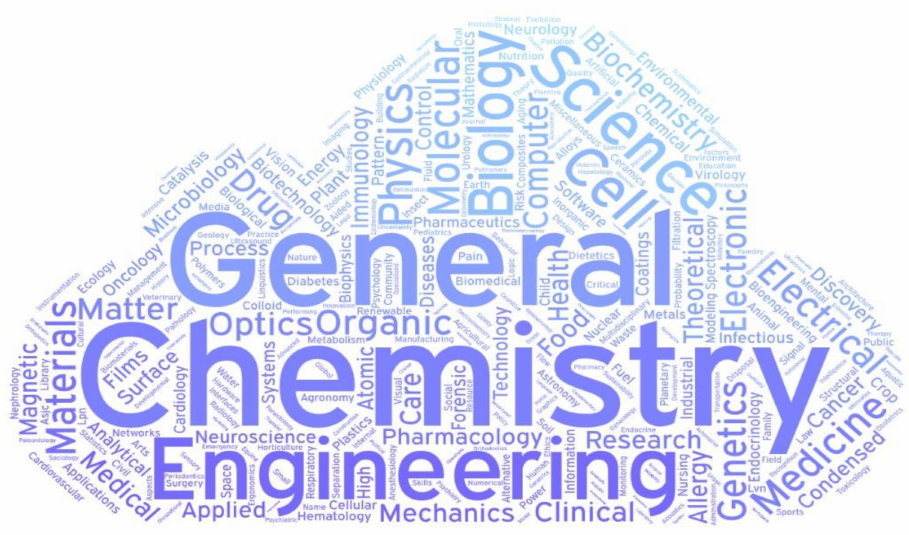
Figure 8. Cloud Word of Topic cluster